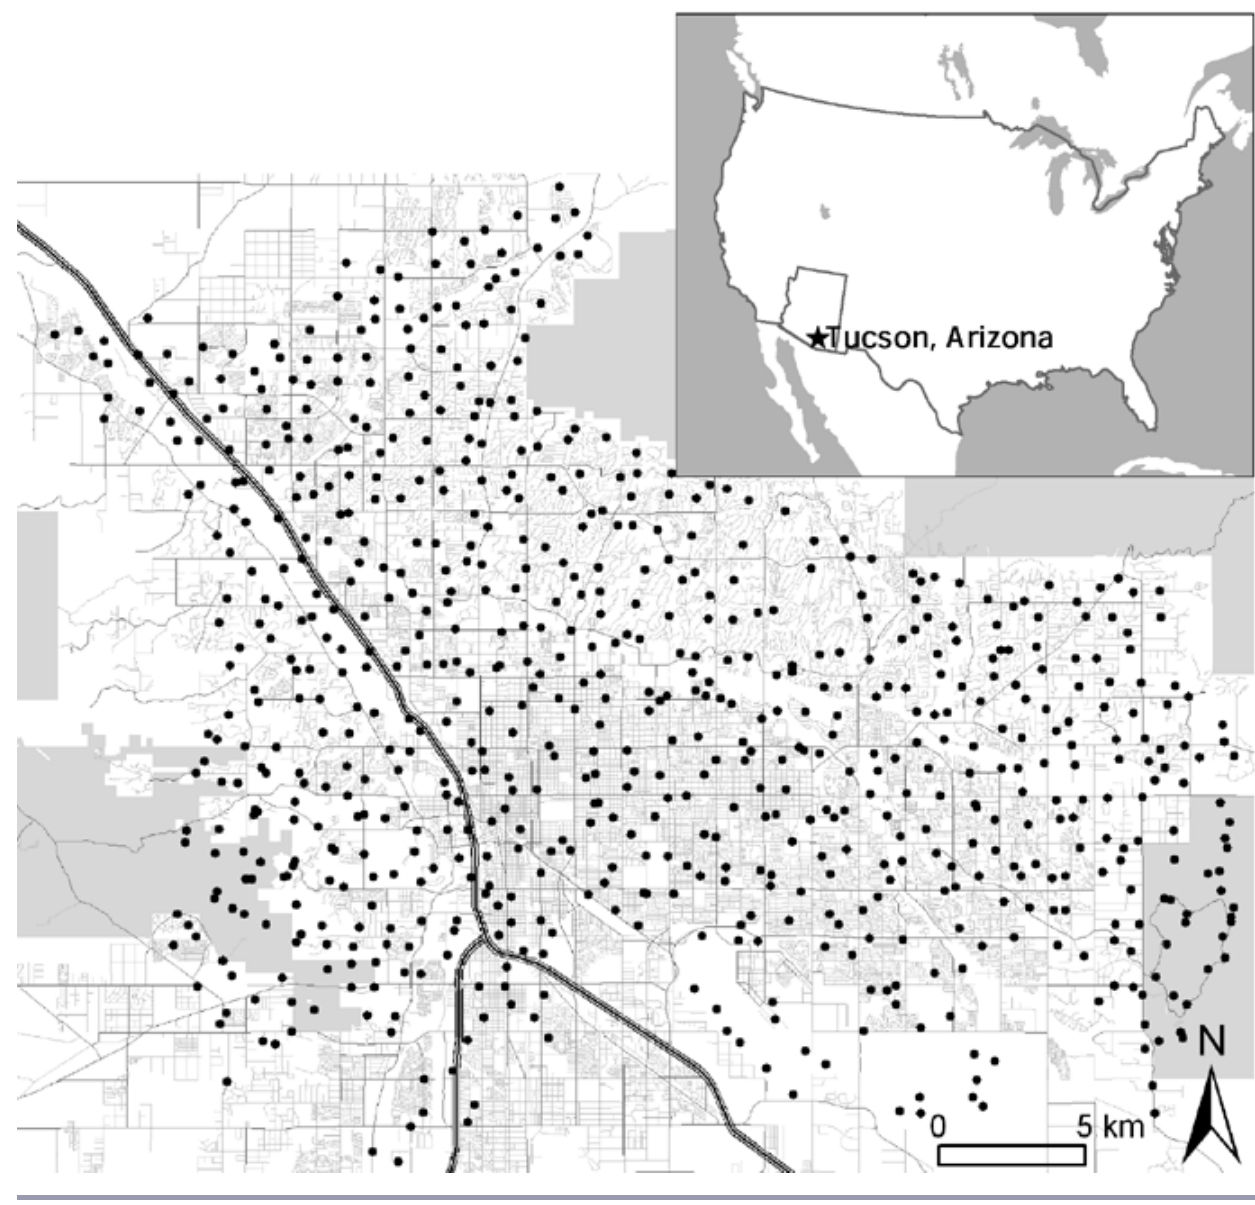
Fig. 2. Map of Tucson study area showing roads a gray lines, interstate highways as divided lines, nature reserves in gray shading, and 725 survey points as dots. Inset shows position of Tucson in western United